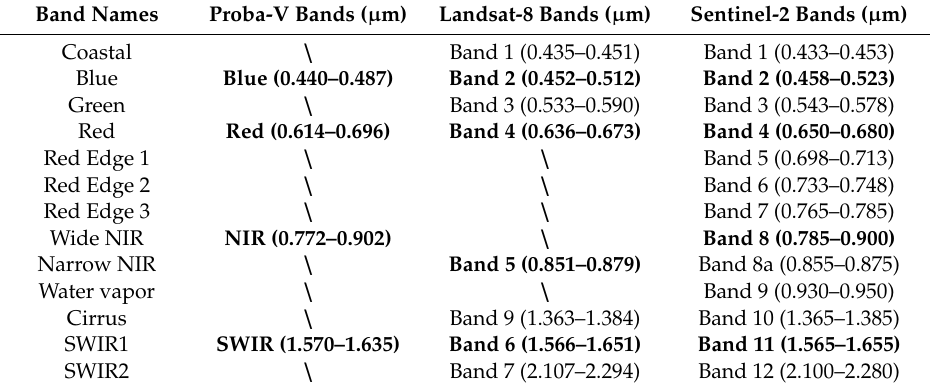
Table 2. The spectral bands of Landsat–8 and Sentinel-2 data used in this paper. The overlapping bands used for collecting training samples (Section 3.1) are highlighted in bold